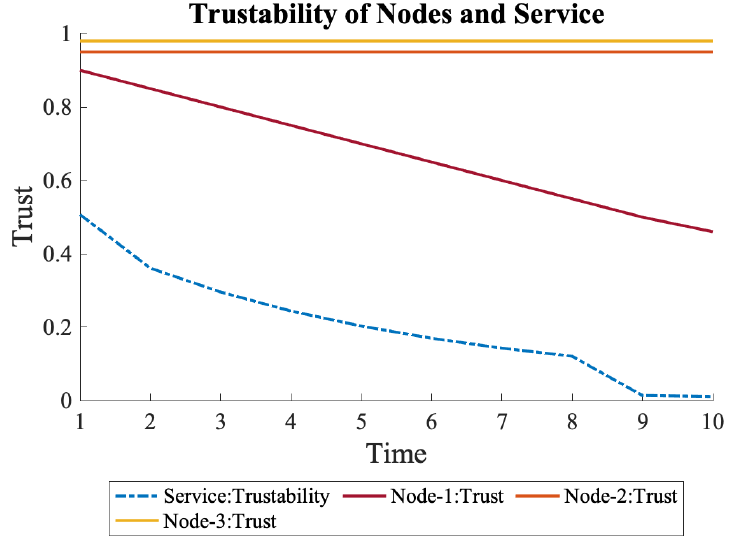
Figure 11. When trust of N1 continuously declines, its effects on the overall trustability is more